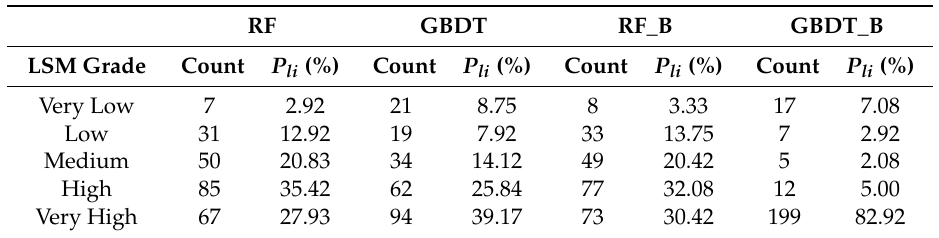
Table 4. Quantitative results for the comparison of historical landslides of each grade in LSMs ( P li is the percentage of historical landslides in each grade to total